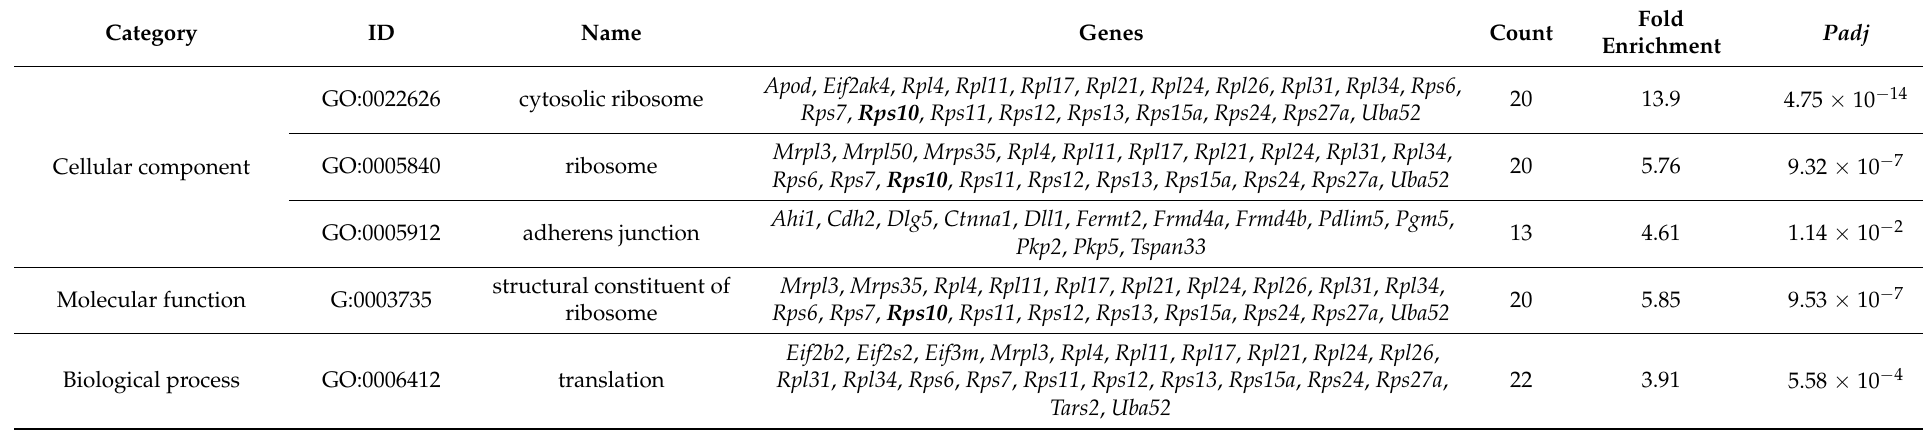
Table 5. Ontological analysis (DAVID) of downregulated genes (consensus and portrait scores < − 2) after FLX treatment in stressed animals.